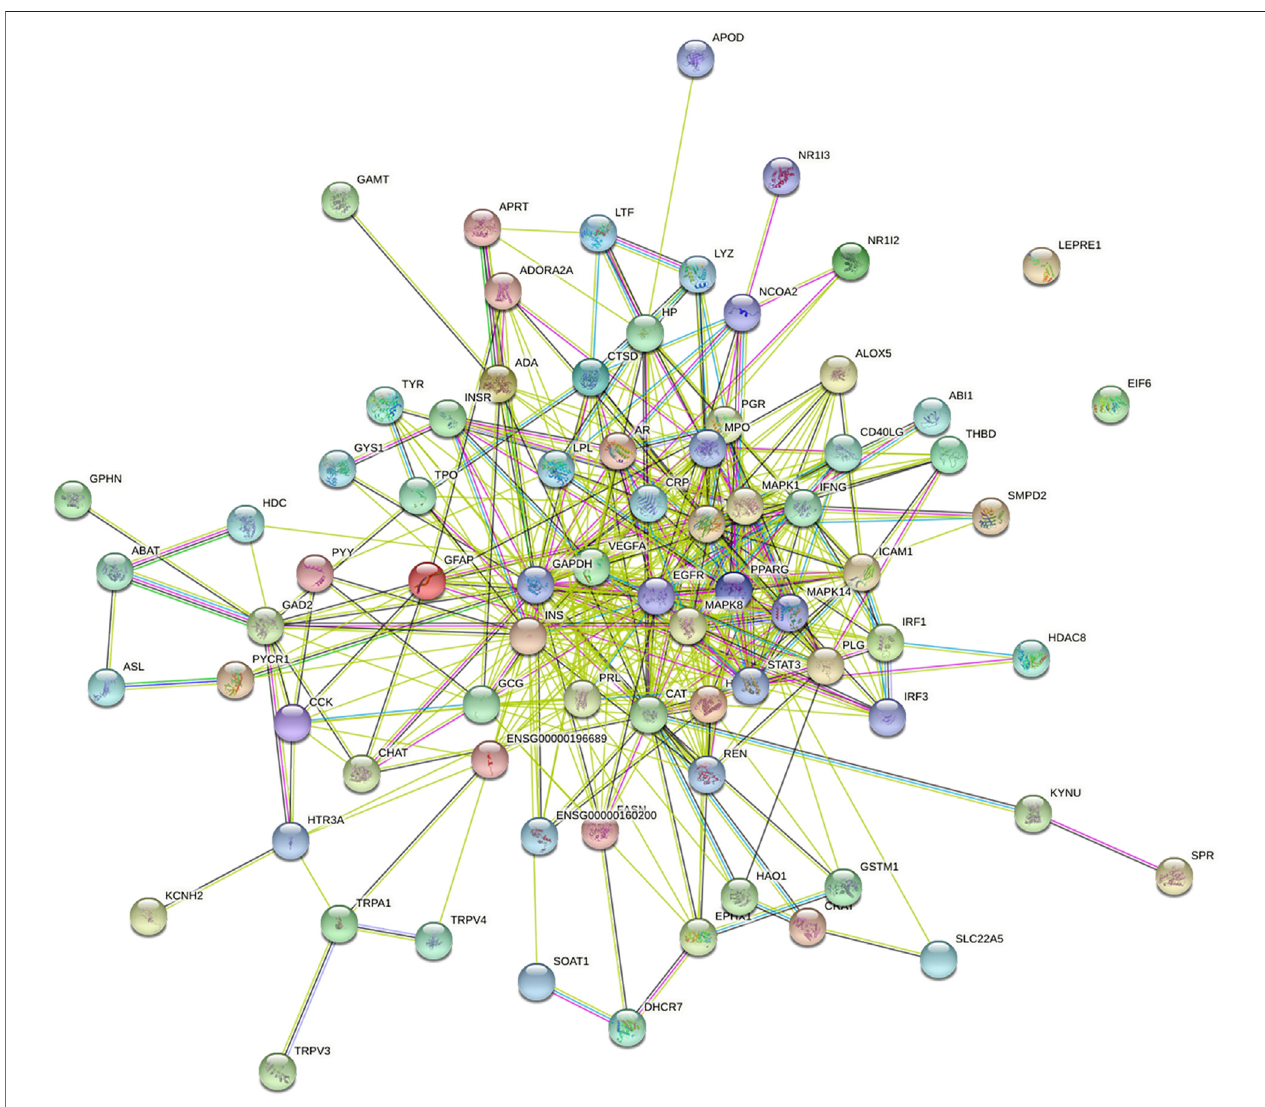
FIGURE 7 | The PPI network of targets between NFPX and ARDS. Each node represents a protein and edges represent protein – protein associations.